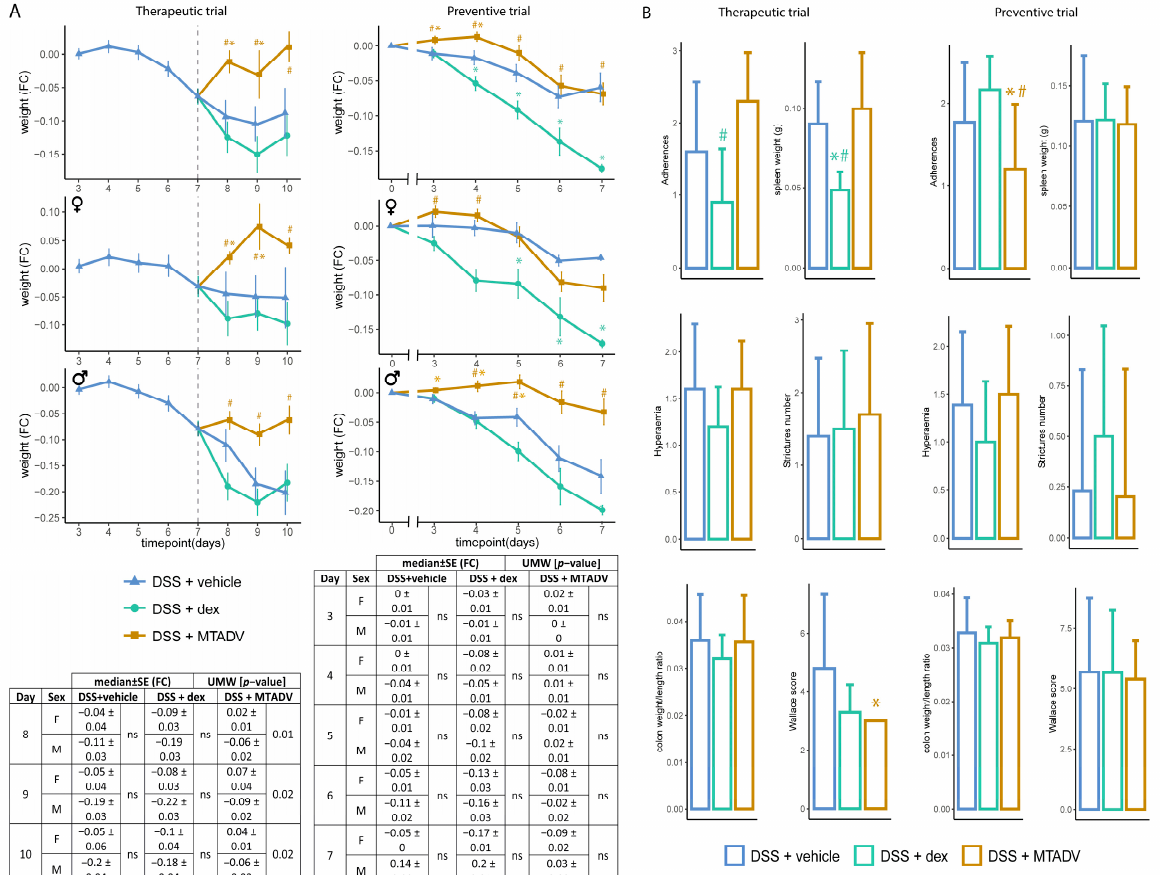
Figure 4. Macroscopic evaluations in the follow-up of the DSS model. ( A ) Body weight is represented as median FC ± SE in the follow-up, represents therapeutic and preventive approaches, and is stratified by sex. Colors and dots denote treatment groups. Tables showing the statistical test (UMW) between sexes at each time point are given. ( B ) Morphometric data are represented for both therapeutic and preventive trials. Data are represented as bar plots (median ± SD). Each variable and metric are given on the Y-axis, while colors indicate the treatment group. Asterisks indicate differences between treatments and vehicle administration, whereas pads mark differences between dexamethasone and MTADV treatments at each time point (Kruskal–Wallis with posthoc Dunn’s test). Significance levels: */ # 0.01 ≤ p -value ≤ 0.05. BLI, bioluminescence intensity; dex, dexamethasone; DSS, dextran sulfate sodium; F, female; FC, fold-change; M, male; MTADV, 5-MER peptide methionine-threonine-alanine-aspartic acid-valine; SD, standard deviarion; SE, standard error; UMW, U Mann–Whitney